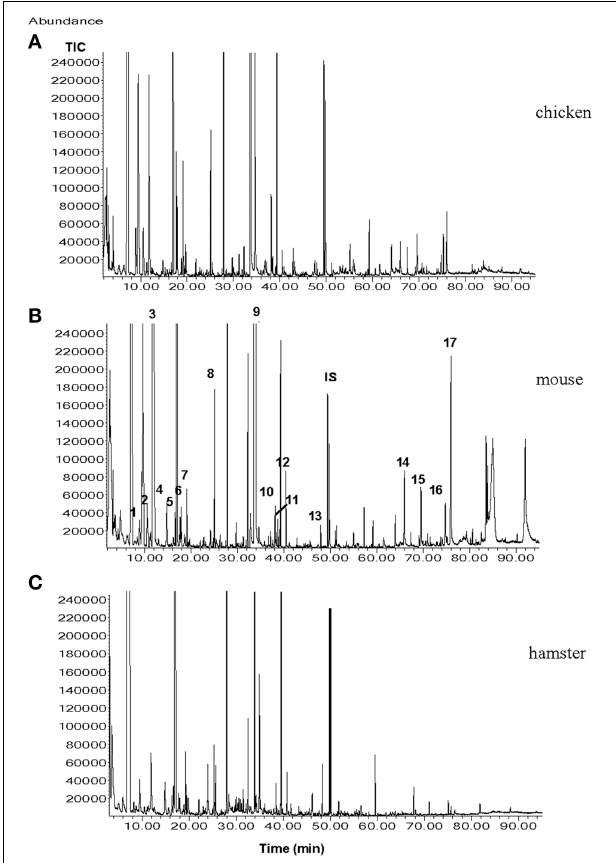
FIGURE 2 | Total ion chromatograms (TICs) from the male ferret urine samples when ferrets were fed with (A), chicken; (B), mouse; (C), hamster. Numbers indicate the following compounds 1, xylene; 2, heptanal; 3, 2,5-dimethylpyrazine; 4, benzaldehyde; 5, 6-methyl-5-hepten-2-one; 6, 2,3,5-trimethylpyrazine; 7, 2-ethenyl-6-methylpyrazine; 8, non-anal; 9, quinoline; 10, o-aminoacetophenone; 11, 2-methylquinoline; 12, 2-methylquinazoline; 13, geranylacetone; 14, tetradecanoic acid; 15, pentadecanoic acid; 16, 9-hexadecanoic acid; 17, hexadecanoic acid; IS internal standard (7-tridecanone) (Graph taken from Apfelbach et al.,